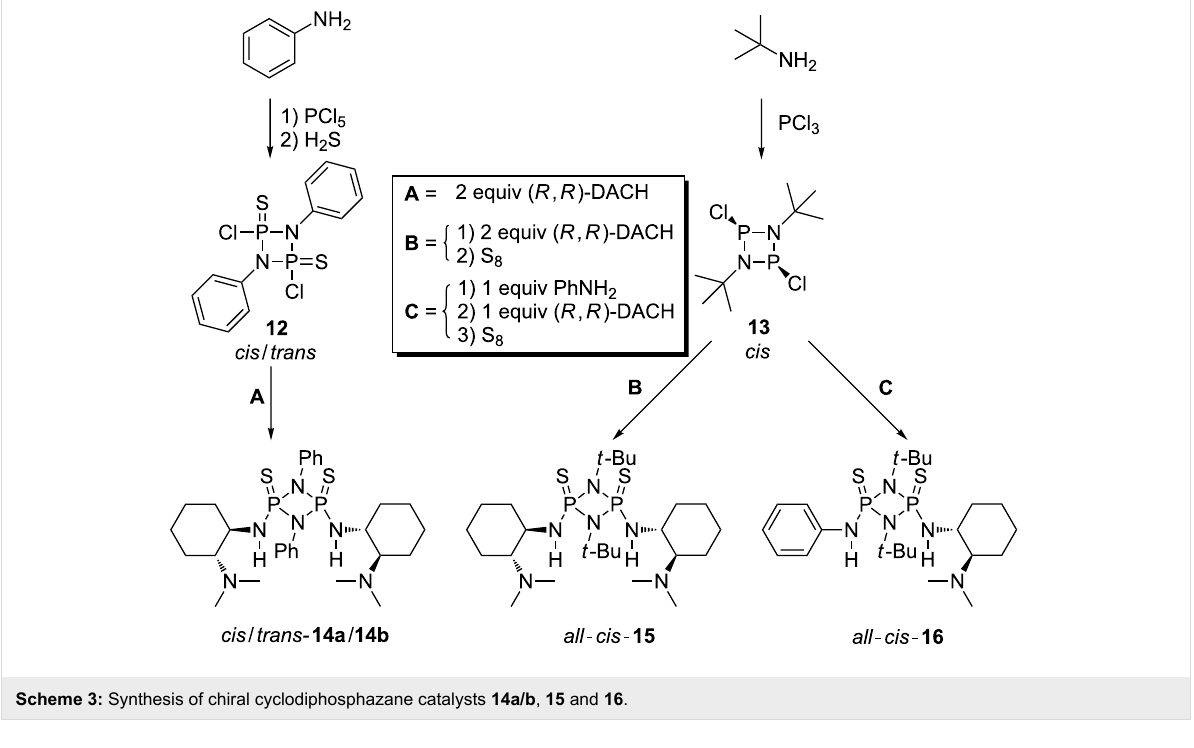
Scheme 3: Synthesis of chiral cyclodiphosphazane catalysts 14a/b , 15 and 16 .